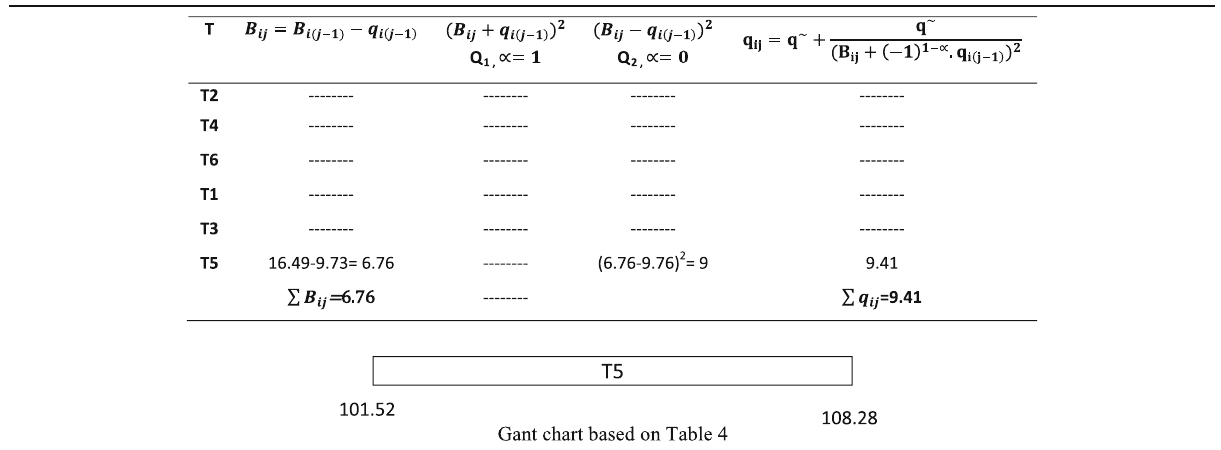
Table 4 Task quantum calculations in the third